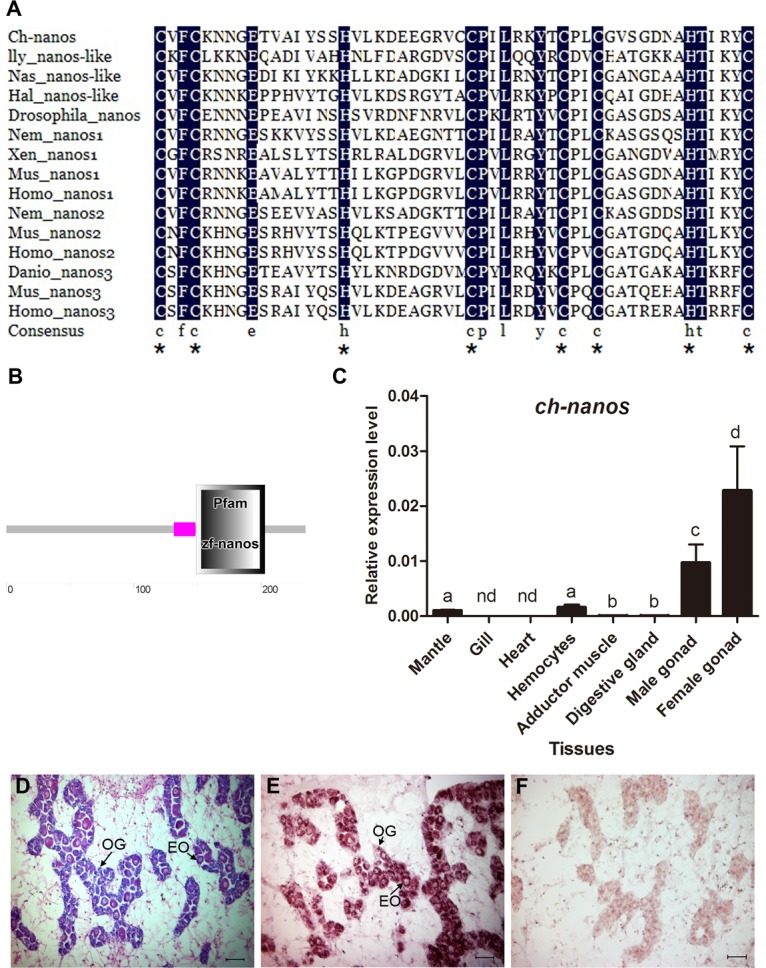
Analysis of Nanos ortholog identified in C.hongkongensis transcriptome.(A) Amino acid sequence alignment of the nanos RNA-binding domain predicted in the Ch-nanos with that of other Nanos orthologs. Two highly conserved CCHC zinc finger motifs are indicated by asterisks. For the GenBank accession numbers of the reference sequences, see S3 Table. (B) Domain structure of Ch-nanos. (C) Expression profile of in Ch-nanos adult tissues by qRT-PCR with mean±s.e.m. as error bars (n = 5). nd: not detected. (D) Histological analysis of C.hongkongensis female gonad at early developing stage. (E) Expression profile of Ch-nanos in early developing stage female gonad detected by ISH with antisense and sense probe. (F) Positive cells are stained in purple.OG: oogonia; EO: early vitellogenic oocyte.